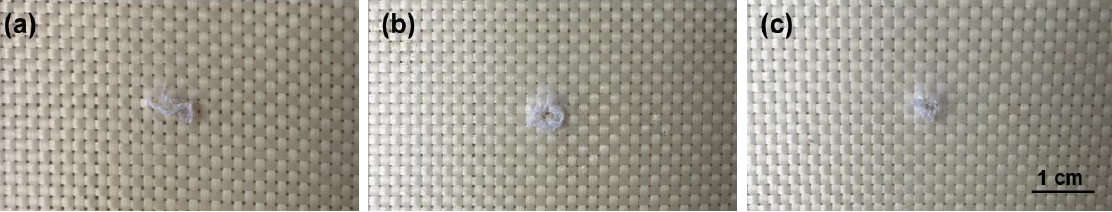
Figure 10. Images of punctured Kevlar/TPU laminated composites as related to the thickness of ( a ) 1, ( b ) 1.2, and ( c ) 1.5 mm.